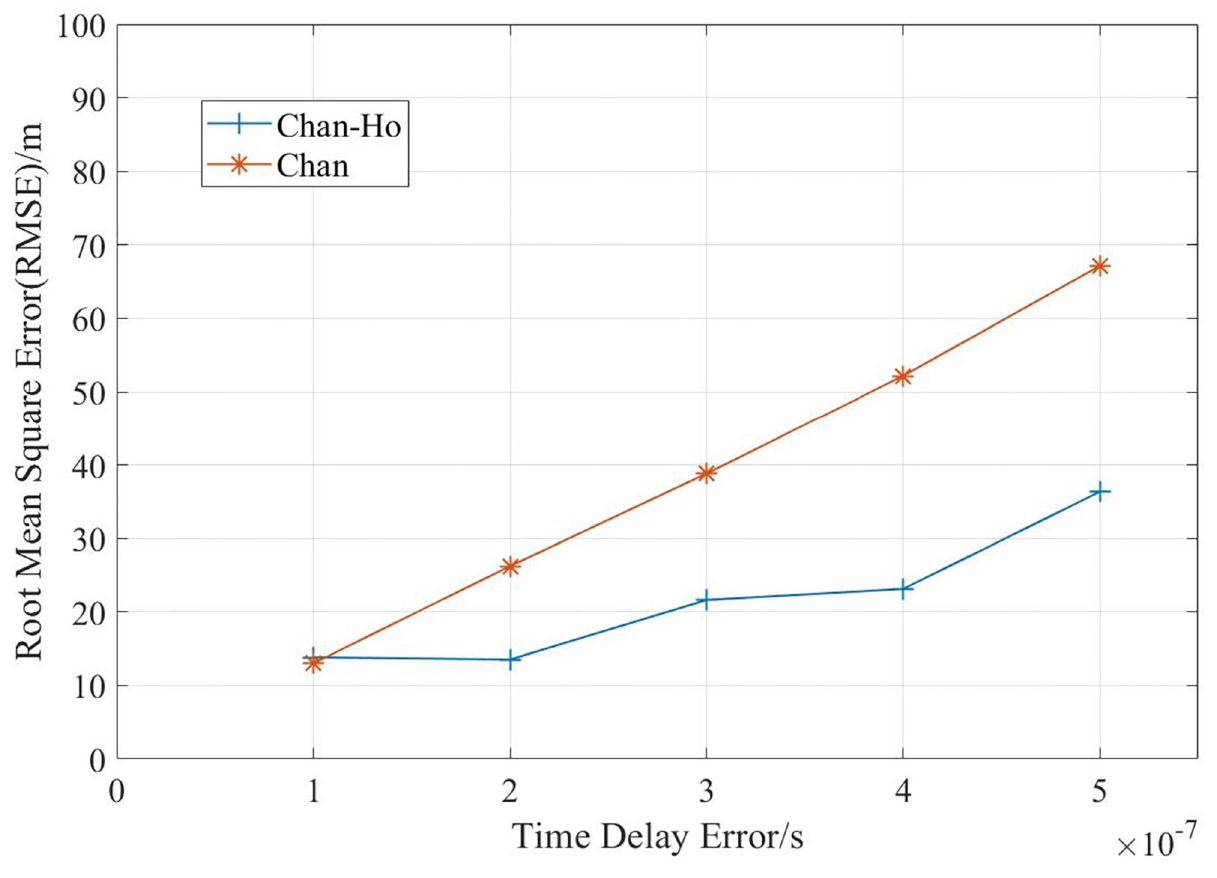
Fig 9. Comparison of Chan and Chan-ho with different delay difference